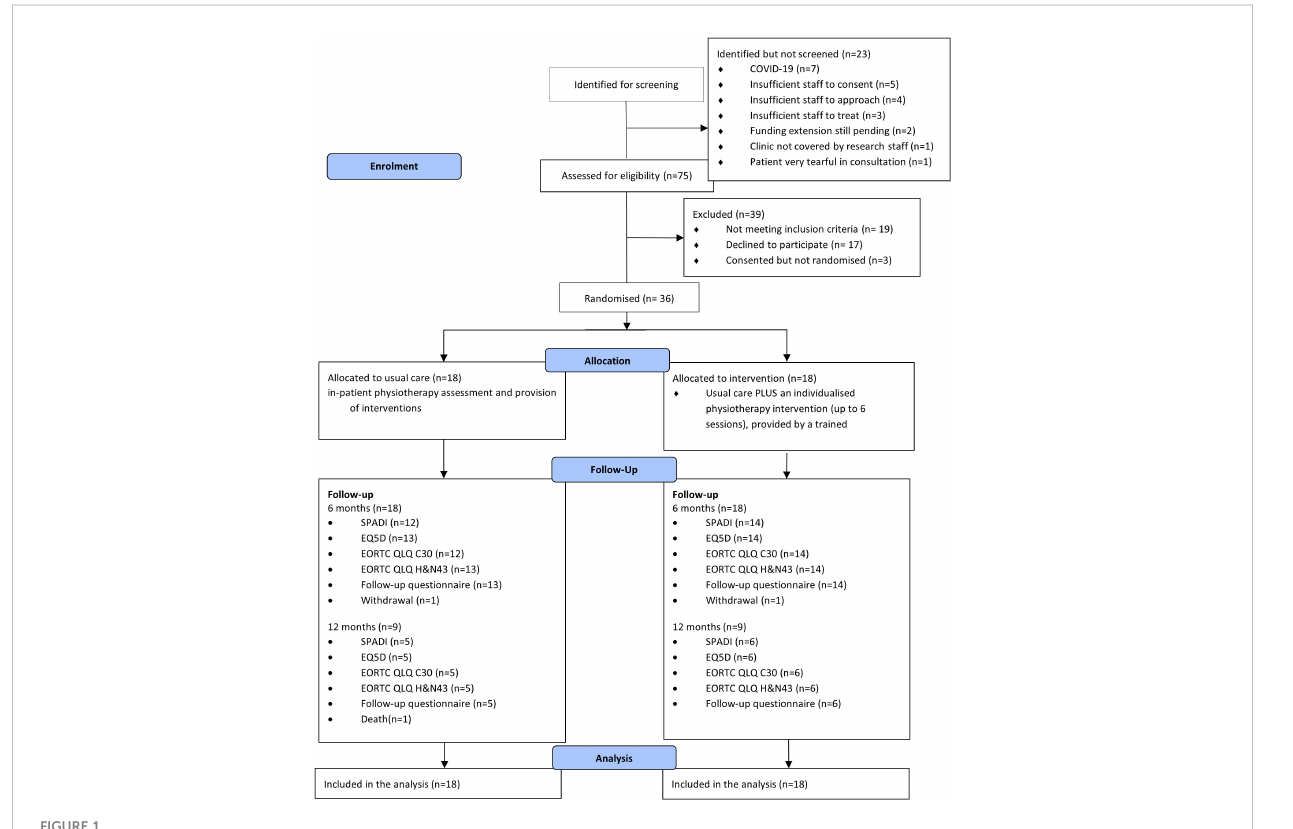
FIGURE 1 CONSORT diagram from screening to